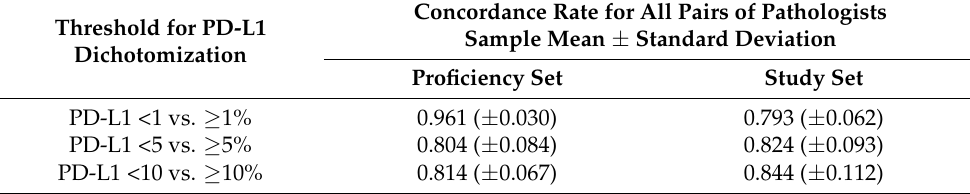
Table 6. Exploratory analysis of three different thresholds for dichotomization of PD-L1 scores, and their influence on the concordance among all ten participating